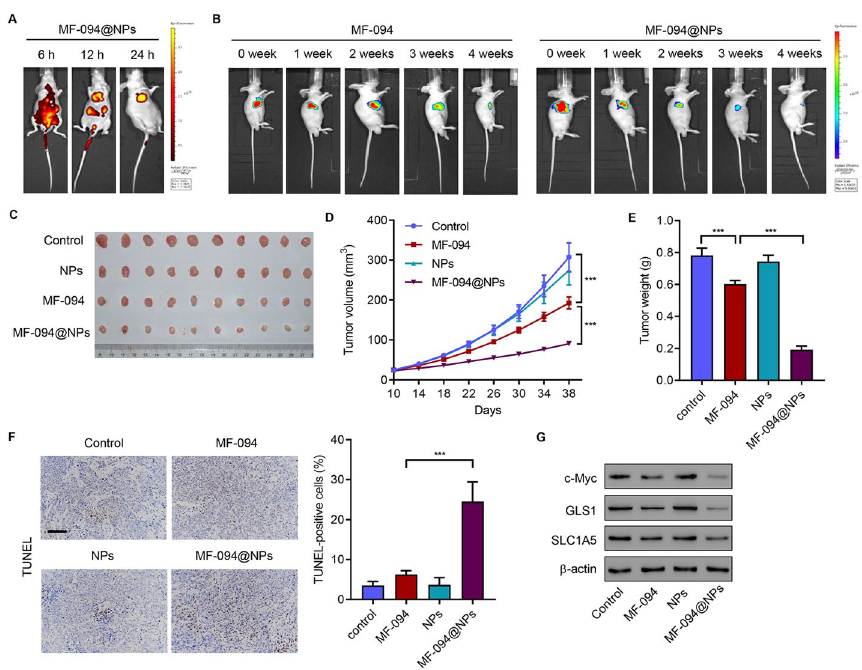
Fig. 7 In vivo antitumor efficacy of MF-094@NPs. A Representative fluorescence (MF-094@NPs) and B bioluminescence (SCC4 cells) imaging of SCC4 cell subcutaneous injection-induced xenograft tumor model after intravenous MF-094 or MF-094@NPs injection (1 mg/kg/day). C Sample images of tumor among mice bearing SCC4 cells with different treatments. Tumor volume D and weight E . F TUNEL-positive cells were analyzed in different groups (scale bars: 100 μm). G Xenograft mouse tumors showing c-Myc, GLS1, and SLC1A5 expression. *** P <